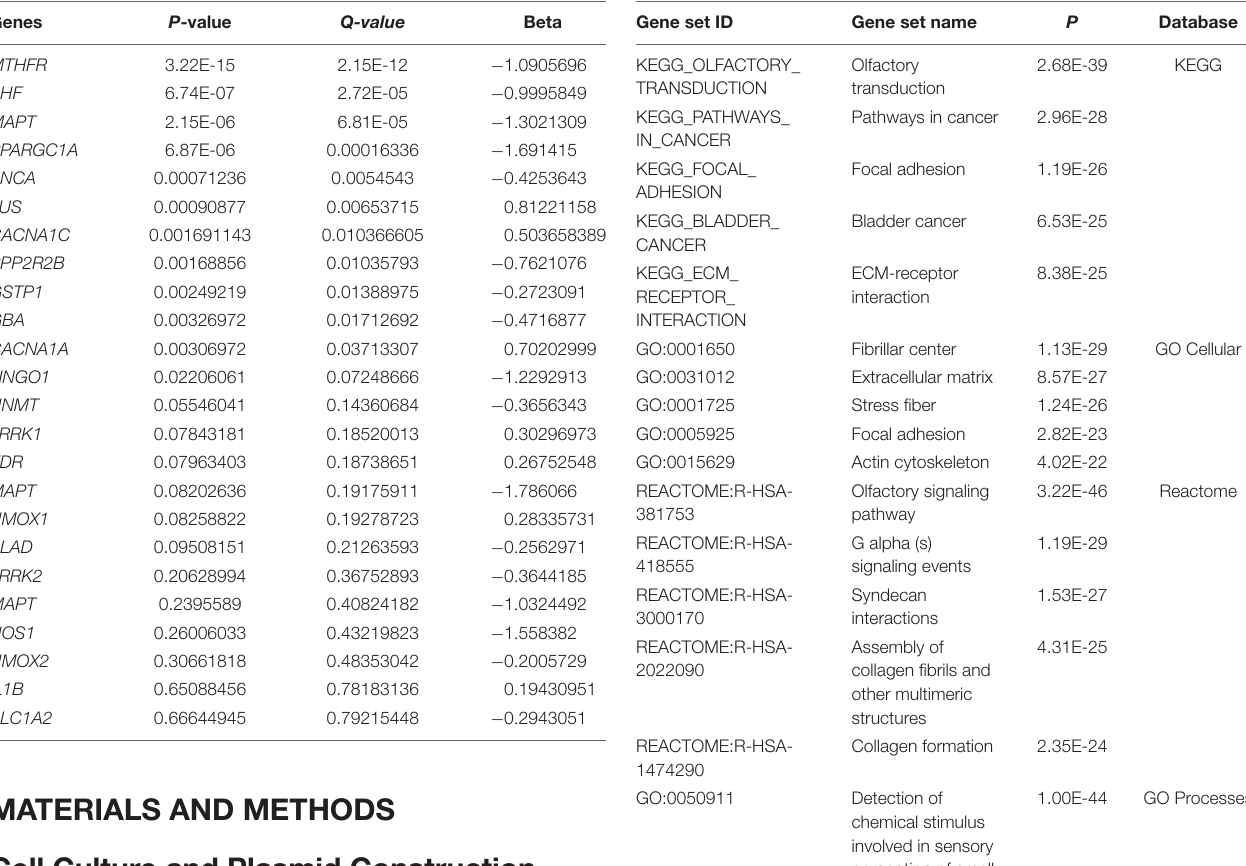
TABLE 1 | Effects of STK32B perturbation on ET-implicated genes. TABLE 2 | Gene ontology and pathway analyses of differentially expressed